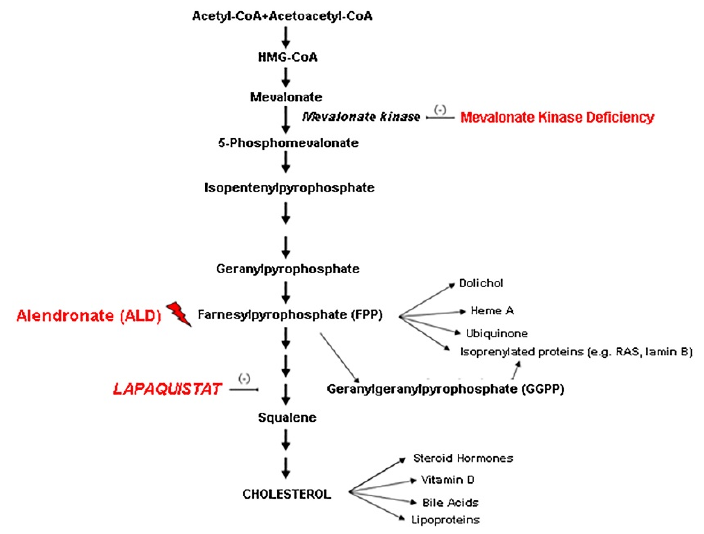
Figure 1. Schematic representation of the mevalonate pathway.